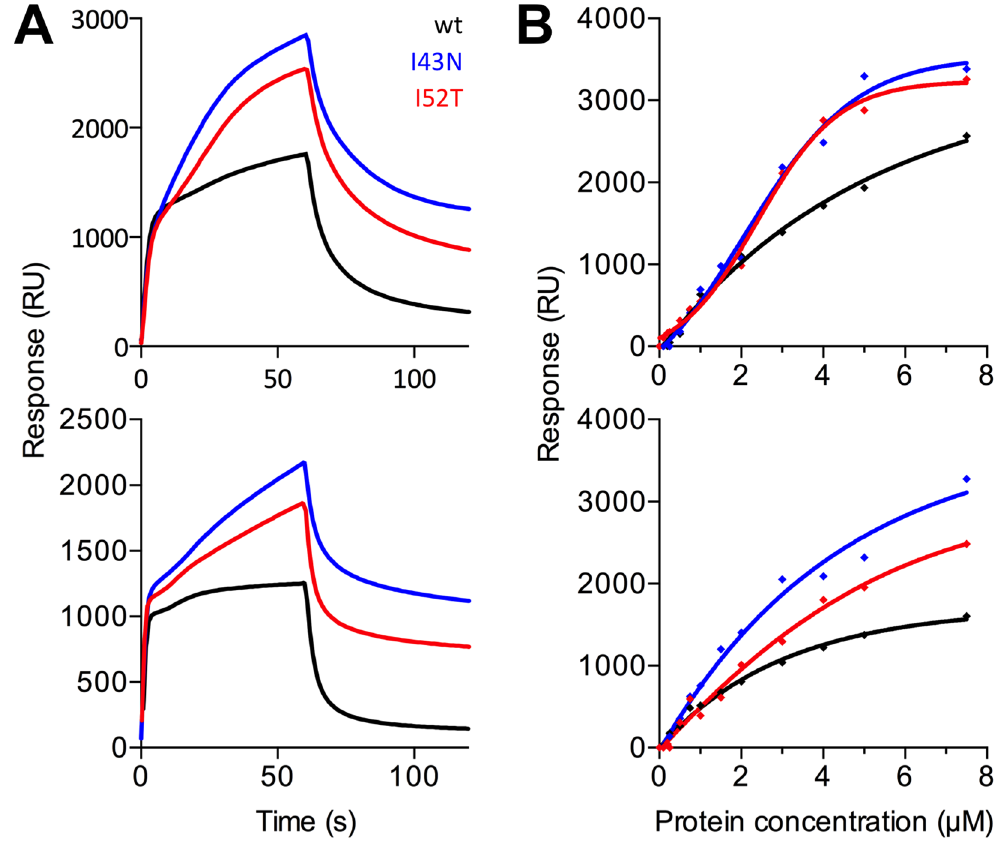
Figure 4. Membrane surface binding. ( A ) DMPC:DMPG (top) and DOPC:DOPG (bottom) sensorgrams with injection of 4 µ M protein. ( B ) DMPC:DMPG (top) and DOPC:DOPG (bottom) fits for a protein titration.